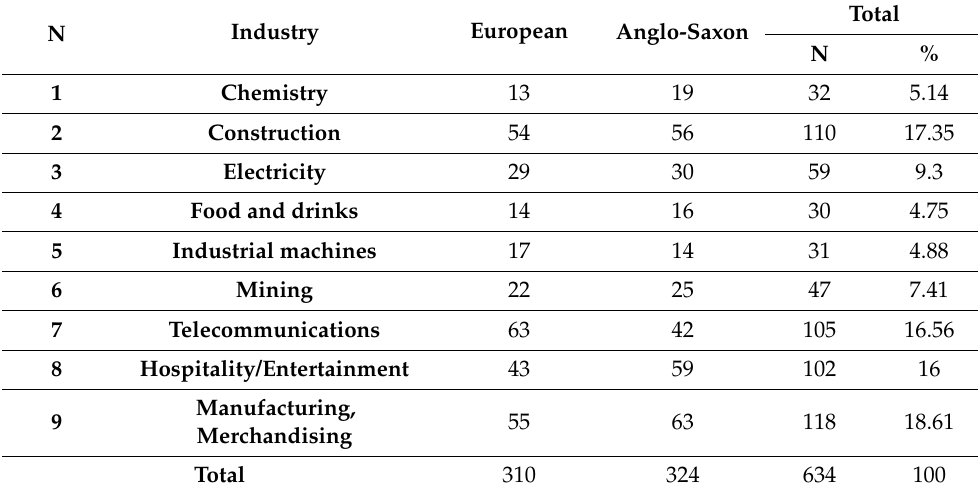
Table 1. Industry